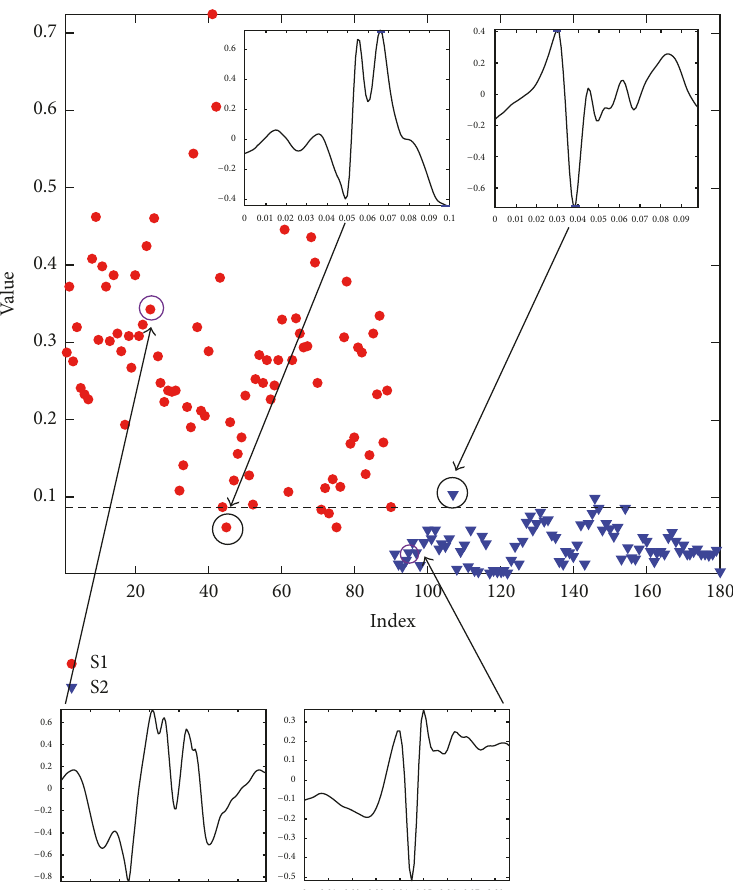
Figure 4: Calculated values obtained using the third proposed method for a set of waveforms. Examples of hits and missed candidates are presented in the lower and the upper part of the figure, respectively.